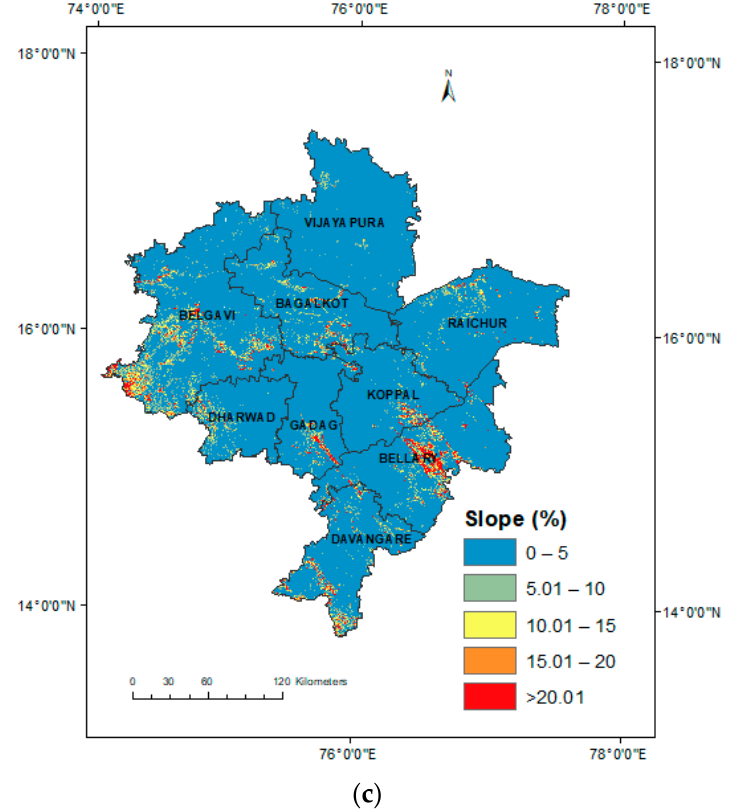
Figure 2. ( a ) Soil map, ( b ) land use land cover map, and ( c ) slope map of northern dry zone of Kar- nataka.